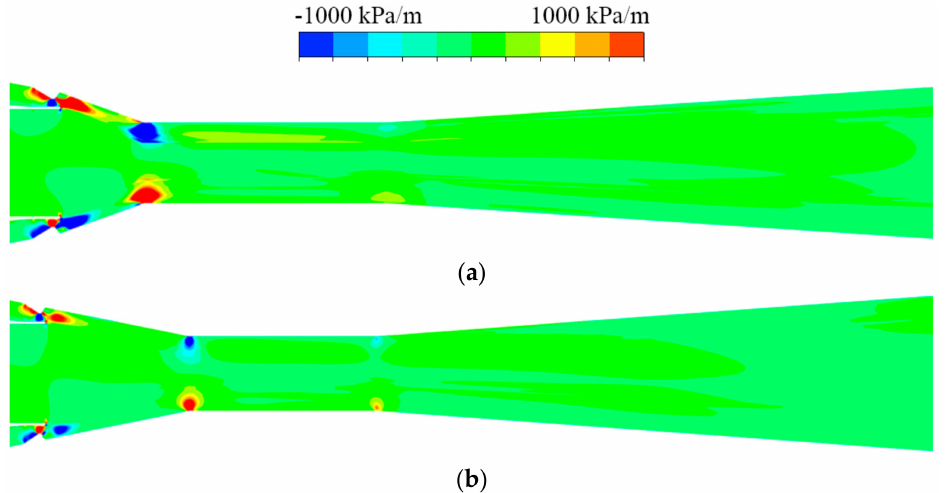
Figure 8. Internal radial pressure gradient before and after optimization. ( a ) Before optimization; ( b ) After optimization.